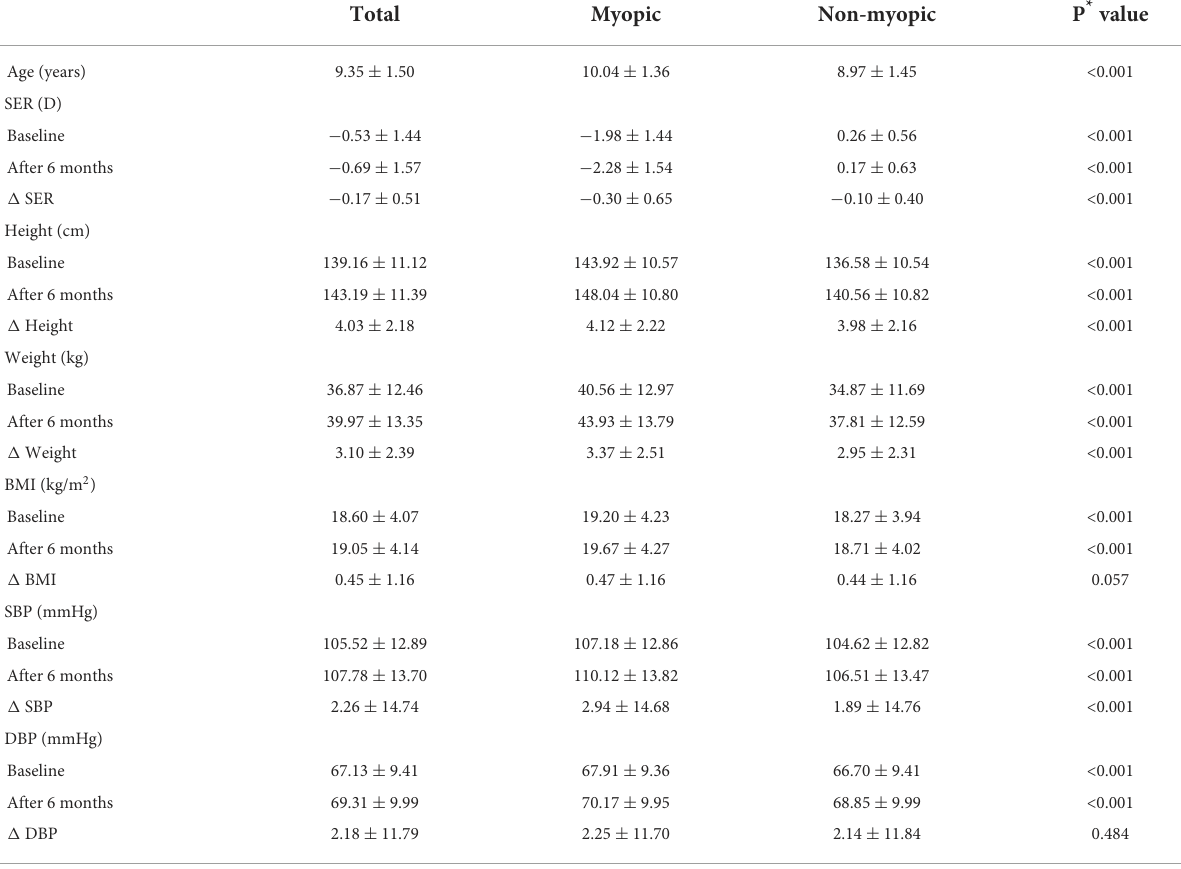
TABLE 1 Summary of the characteristics of the